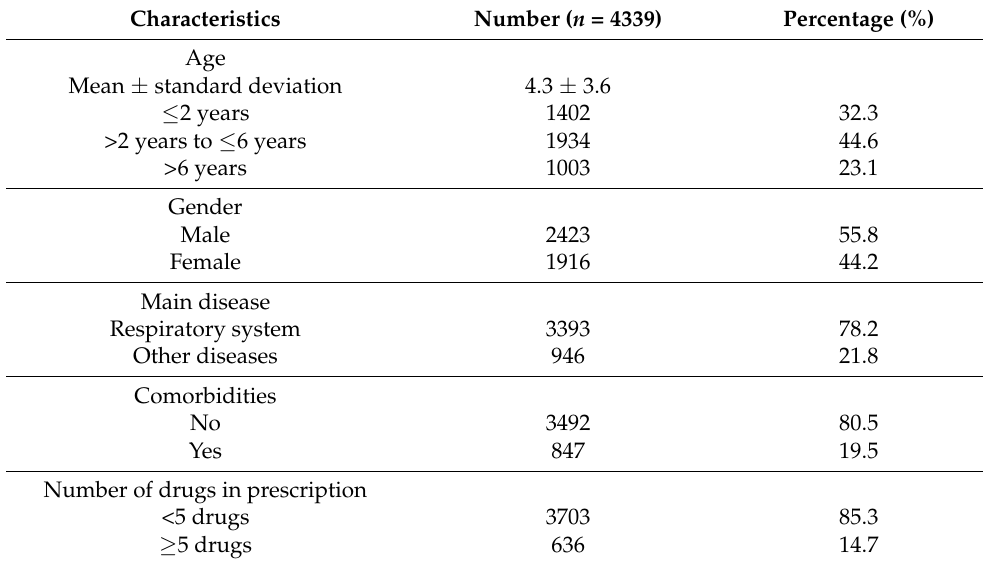
Table 2. Characteristics of the study